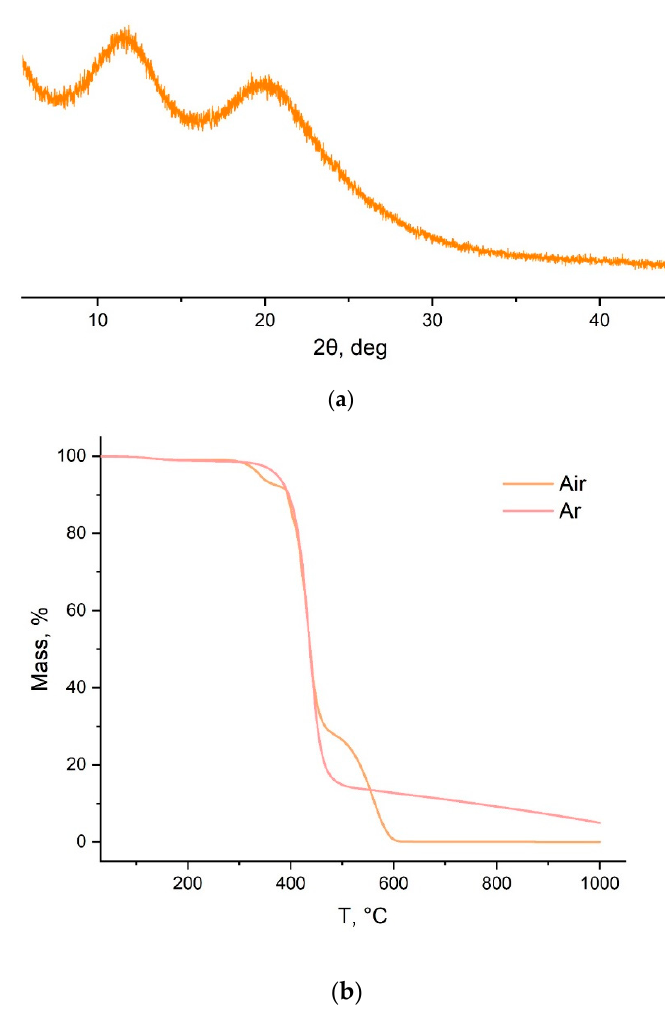
Figure 4. Wide-angle X-ray diffraction (WAXD) pattern ( a ) and TGA curves ( b ) for polyNBi. Table 2. WAXD data for polyNBi in comparison with unsubstituted metathesis polynorbornene (polyNB).